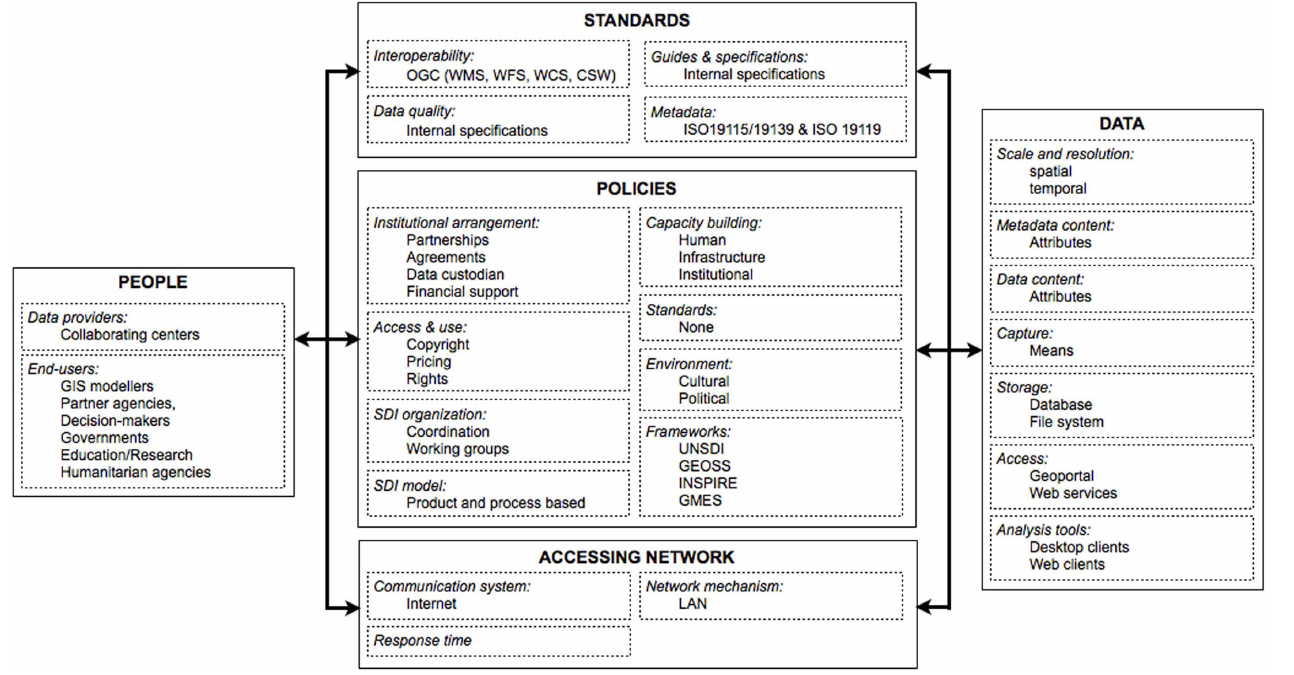
Fig. 1. PREVIEW SDI conceptual model (adapted from Mansourian et al., 2006; Rajabifard, 2002).